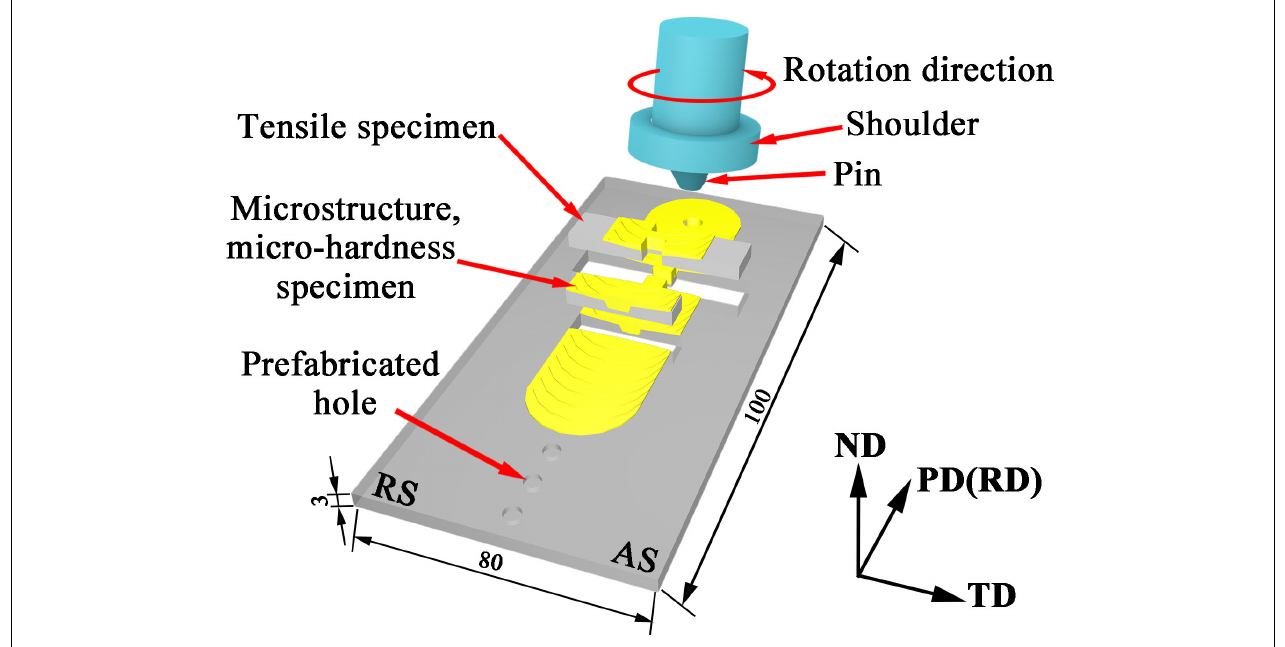
FIGURE 2 | Schematic of the FSP. (AS and RS represent the advancing and retreating sides, respectively. PD, TD, and ND represent processing, transverse, and normal directions, respectively. Unit: mm).